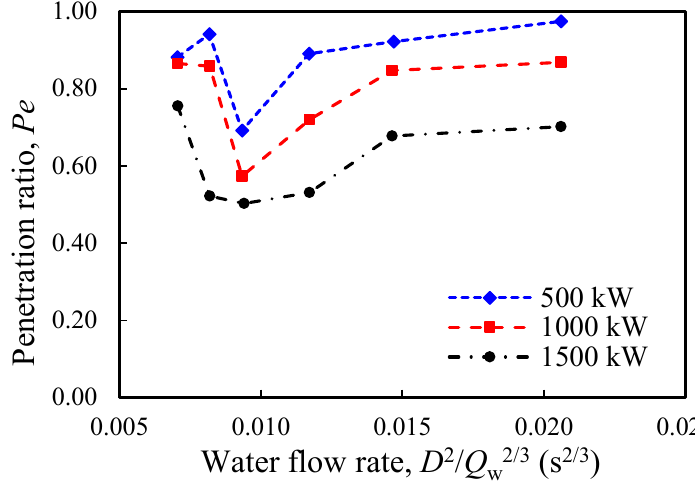
Figure 14. Penetration ratio vs. water flow rates under 6.1 m ceiling [72].